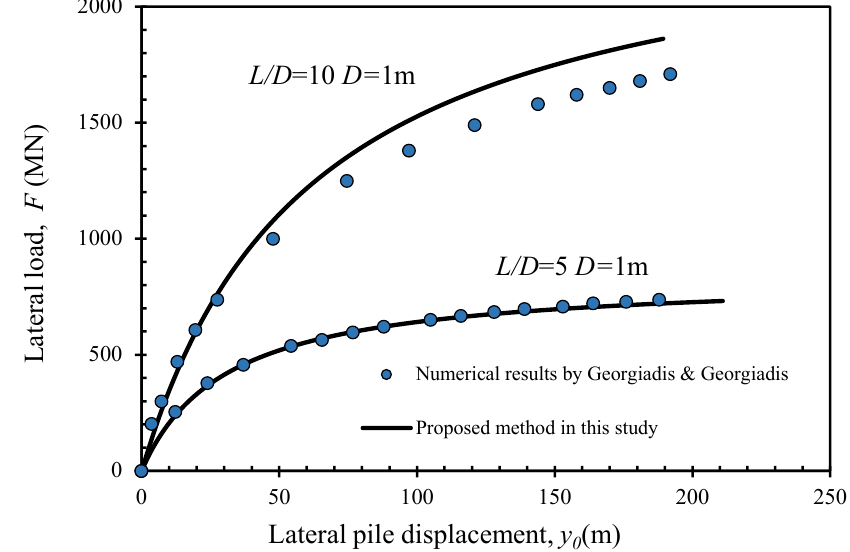
Figure 10. Comparisons of the load displacement results for case 1 [51].